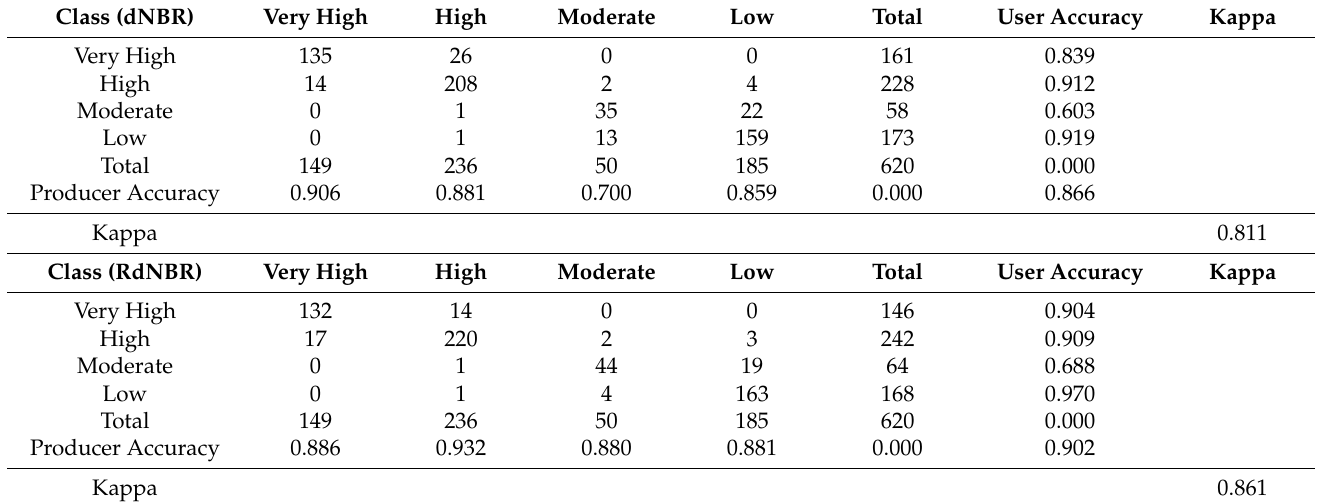
Table 4. Error matrices of bushfire severity classification for dNBR and RdNBR methods.